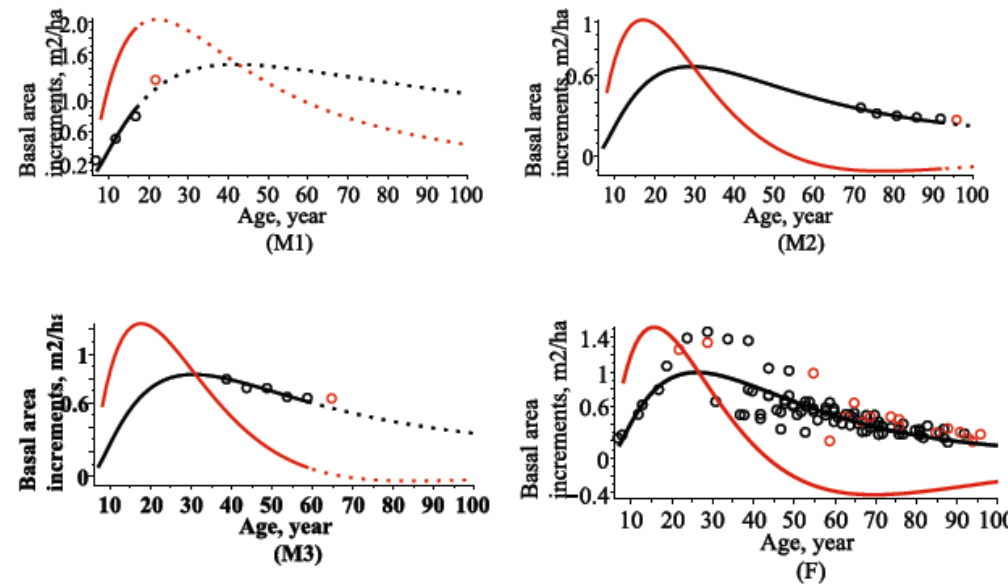
Figure 7. Evolution of current and mean annual basal area increments over age. ( M1 ) mixed effects scenario for the first stand; ( M2 ) mixed effects scenario for the second stand; ( M3 ) mixed effects scenario for the third stand; ( F ) fixed effects scenario for all stands; black solid line–MAI G prediction curve; black dot line–MAI G forecast curve; red solid line–CAI G prediction curve; red dot line–CAI G forecast curve; black circles–estimation dataset, red circles–validation (forecast) dataset.